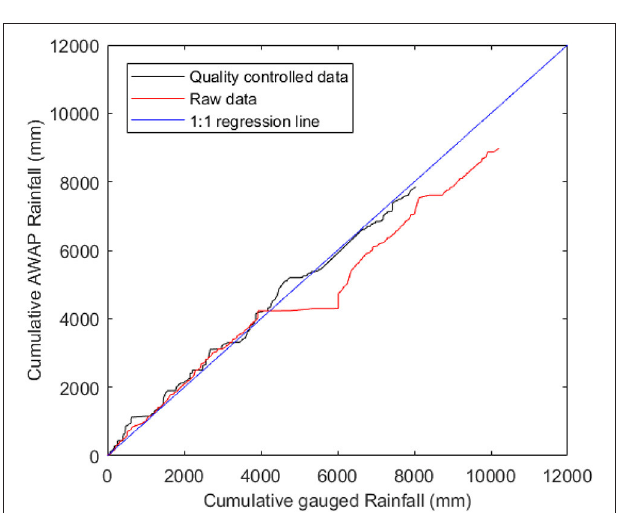
the cross-validation point of view, both Kriging and IDW are recommended, whilst the NN gives the worst